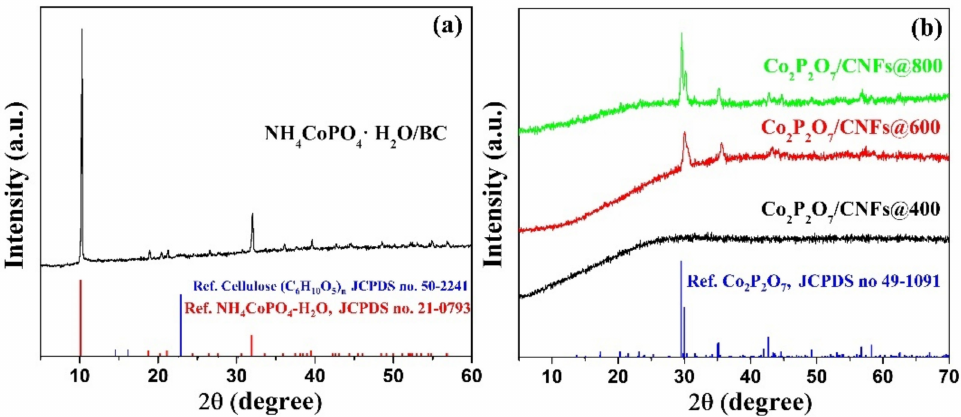
Figure 4. XRD results of ( a ) NH 4 CoPO 4 –H 2 O/BC compared to the references for NH 4 CoPO 4 · H 2 O, cellulose and ( b ) Co 2 P 2 O 7 /CNFs@400, Co 2 P 2 O 7 /CNFs@600, and Co 2 P 2 O 7 /CNFs@800 compared